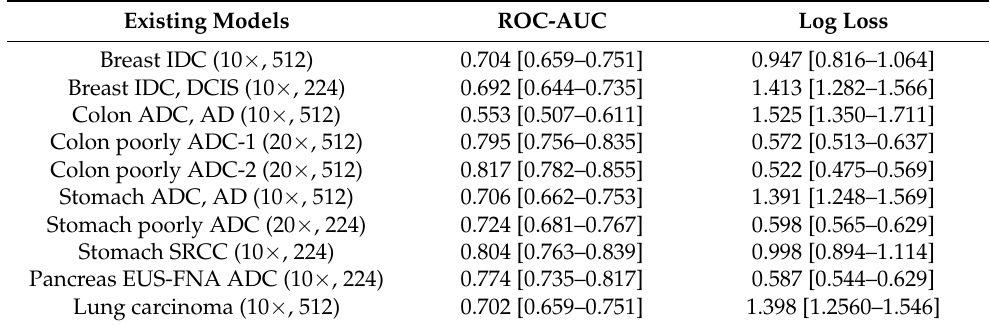
Table 3. ROC-AUC and log loss results for the various existing models on the prostate biopsy test sets.